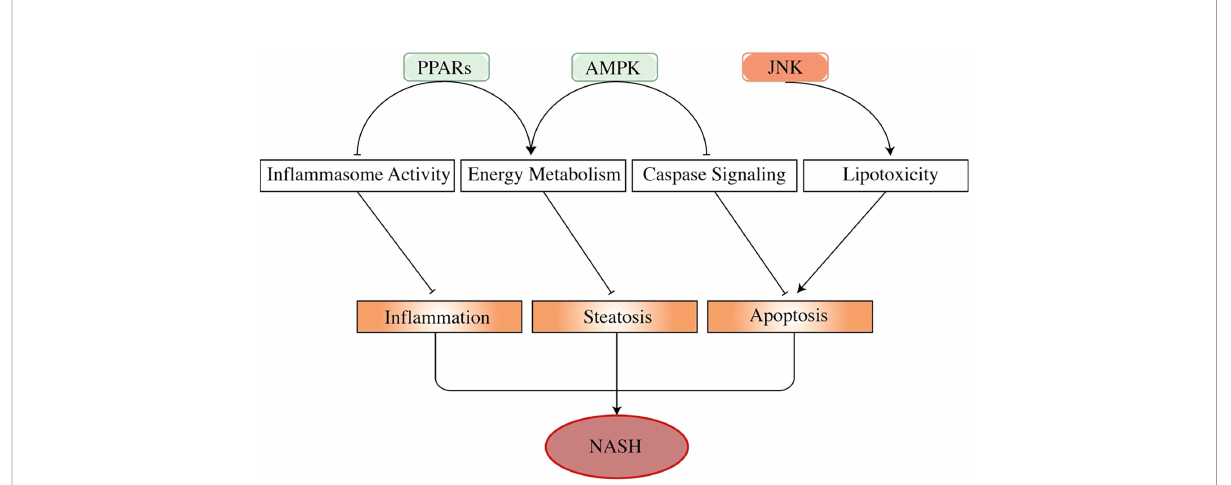
FIGURE 3 The effects of adenosine 5 ′ -monophosphate-activated protein kinase, peroxisome proliferator-activated receptors, and c-Jun N-terminal kinase in the progress of non-alcoholic steatohepatitis. AMPK, PPARs, and JNK are important factors in NASH progression. As energy sensors, PPARs and AMPK regulate energy usage to prevent the liver from developing steatosis. PPARs also show an inhibitory effect on in fl ammasome activity (such as TNF- a and IL-6), thus regulating liver in fl ammation. Activated AMPK attenuates hepatocyte apoptosis by inhibiting the activity of the caspase pathway, especially caspase-6. By contrast, activated JNK promotes liver cell apoptosis by mediating fatty acid-related lipotoxicity and inducing TNF- a activation. These factors play a part in hepatocyte pathogenesis, regulating the progression of NAFLD and NASH. In this fi gure, arrows represent promoting effect, and short lines imply repressing effect. PPARs, peroxisome proliferator-activated receptors; NASH, non- alcoholic steatohepatitis; NAFLD, non-alcoholic fatty liver